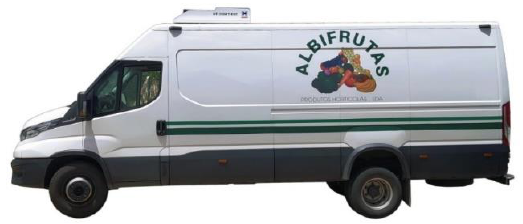
Figure 3. Distribution vehicle example.